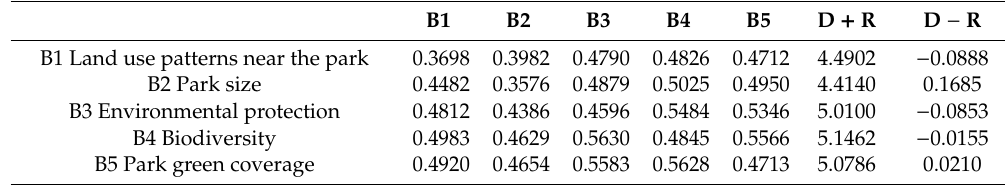
Table 4. DEMATEL results for the ecological